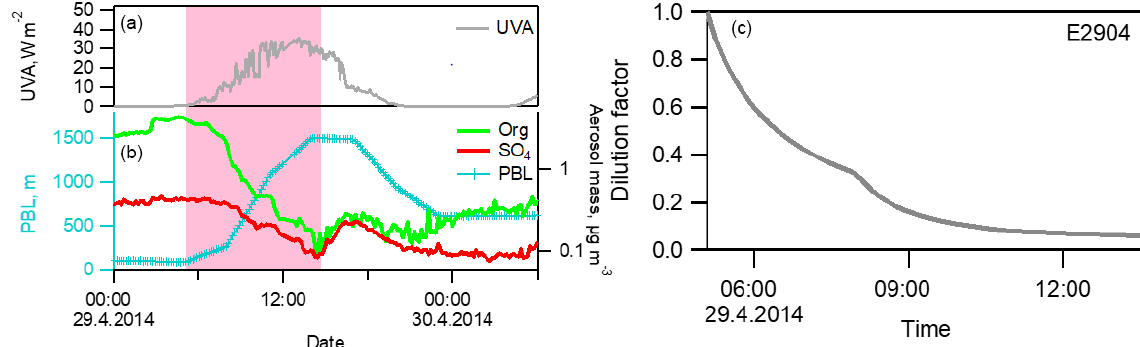
Figure 3. A closer view of the decrease in aerosol mass concentrations coinciding with PBL height development in E2904 (29 April 2014). (a) Ultraviolet (UV)-A radiation forcing; (b) the height of the PBL and the mass concentrations of organic and SO 4 components measured by AMS; (c) dilution factor, estimated from PBL heights.